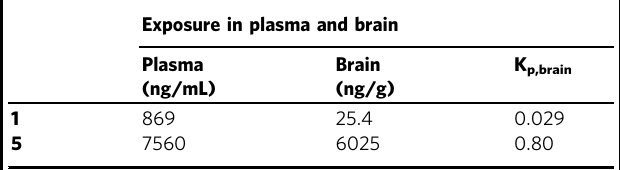
Table 3 Pharmacokinetic pro fi le of compound 1 and compound